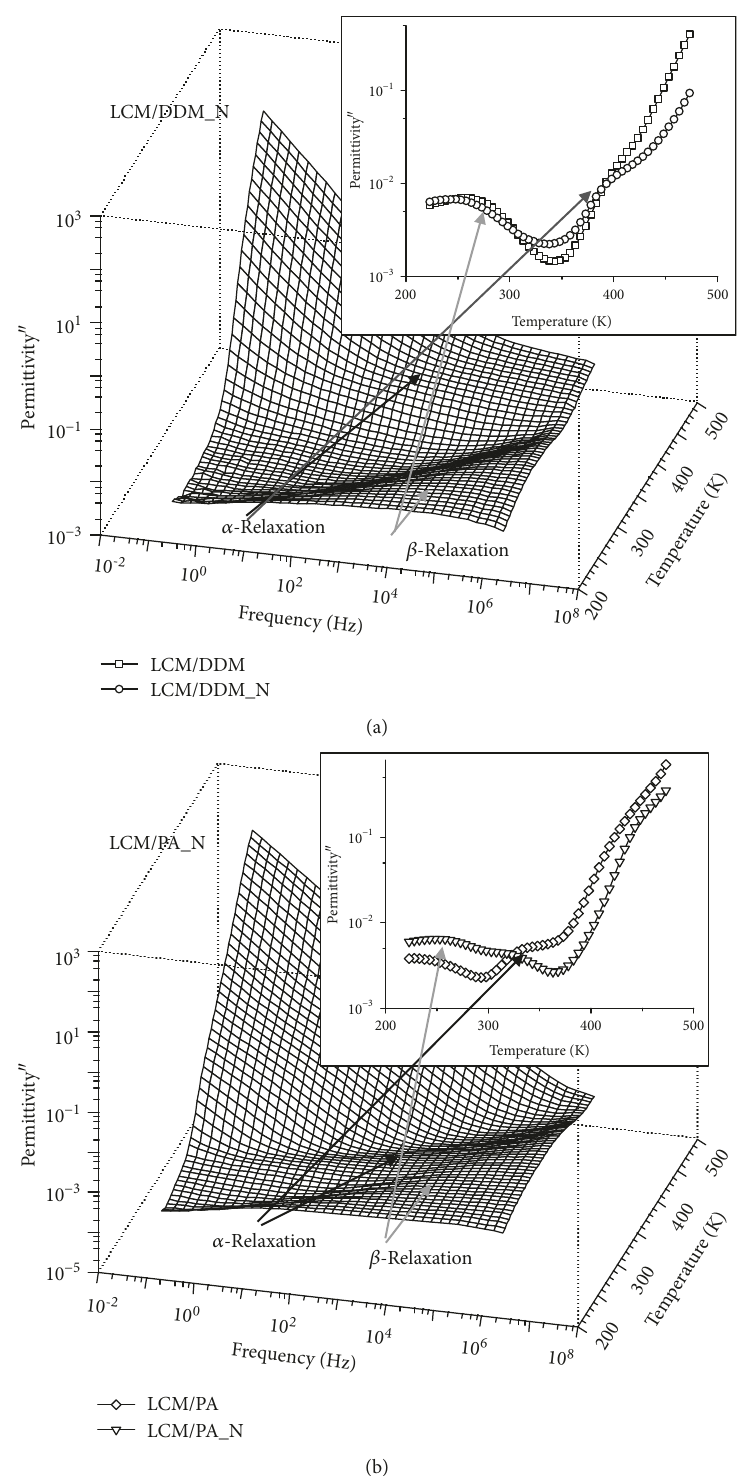
Figure 4: Imaginary part of the complex permittivity, at various temperatures: (a) LCM/DDM with nanorods; (b) LCM/PA with nanorods. Insets: comparative plots of ε ″ T at f = 4 kHz for mixtures cured with and without nano fi